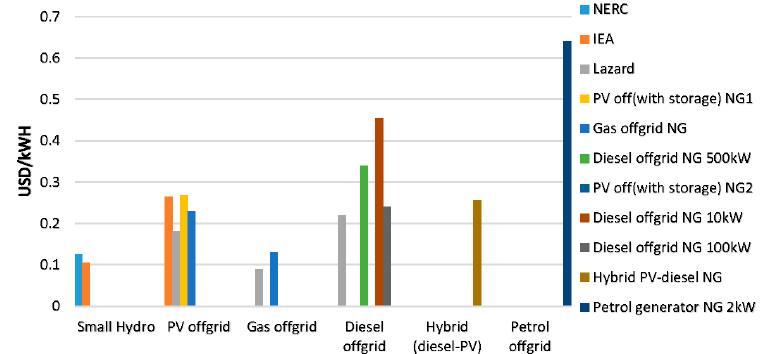
Figure 4. The cost of off-grid electricity generation, based on lcoe: Adapted [14].